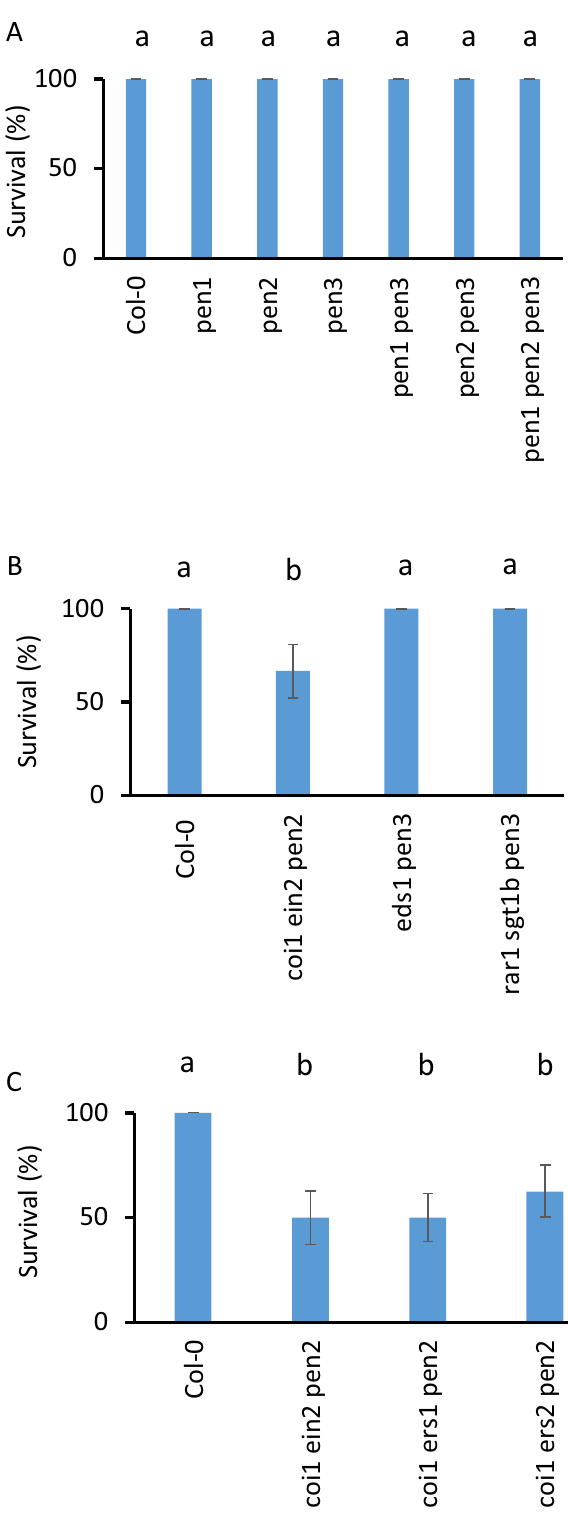
Figure 5. Loss of JA, ET and PEN2 mediated defense pathways compromise resistance to AG8. ( A ) Infection of Col-0, pen1, pen2, pen3, single double and triple mutants with AG8. ( B ) Infection of Col-0, coi1 ein2 pen2 , eds1 pen3 and rar1 sgt1b pen3 mutants with AG8. ( C ) Infection of Col-0, coi1 ein2 pen2 , coi1 ers1 pen2 and coi1 ers2 pen2 with AG8. Three replicate infections of agar grown plants were performed by transferring 4 plants per biological replicate into mock or R. solani infected pots to produce the data in this figure. Plants were scored for survival at 14 days post infection at which point surviving plants had started to flower. An additional independent experimental repeat of this experiment was also performed which confirmed the result (Supplementary Fig. S5). Letters represents significance (adj. p < 0.05) using Fisher’s Exact Test. Error bars represent standard